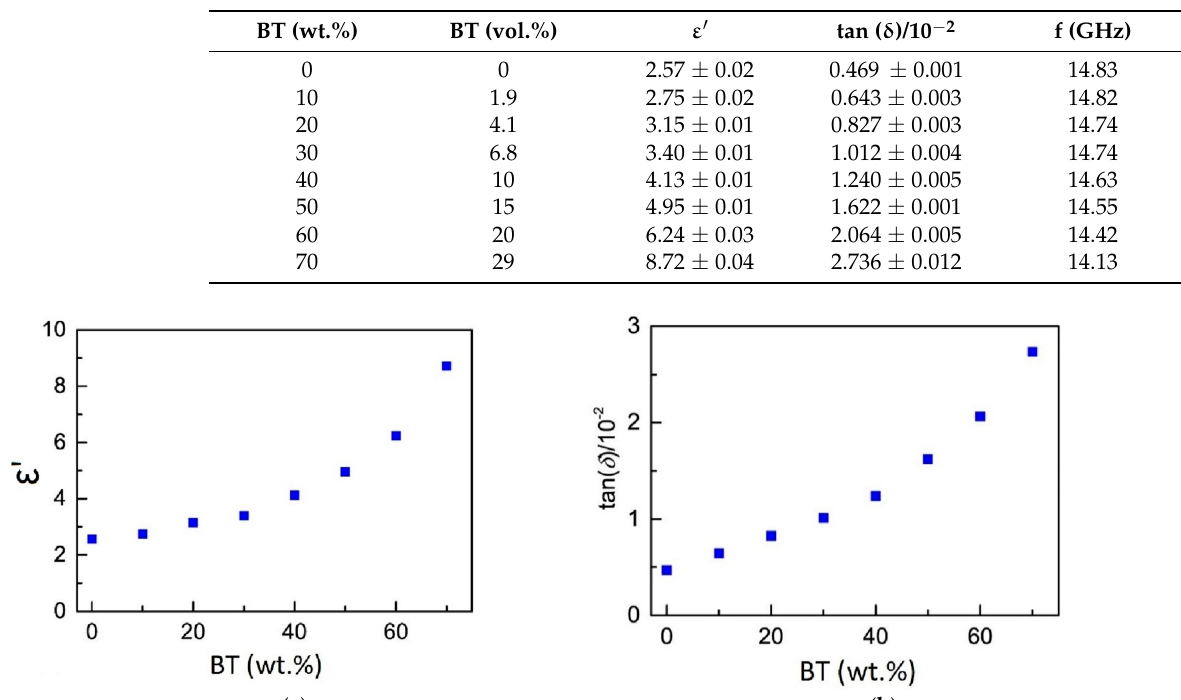
Figure 2. ( a ) 3D-printed sample from ABS polymer (left, ε′ = 2.57) and 50 wt.% BT/ABS polymer composite (right, ε′ = 4.95). Scale: each cubic structure has an overall side length of 32 mm (8 mm unit cell); ( b ) 3D-printed samples with gradient chemical composition using a combination of ABS polymer and 50 wt.% BT in ABS polymer composite. Scale: each cubic structure has a side length of 16 mm (available under Creative Commons license [58]). Table 1. Dielectric properties of 3D-printed polymer composite with various loadings of BT in ABS (available under Creative Commons license [58]).